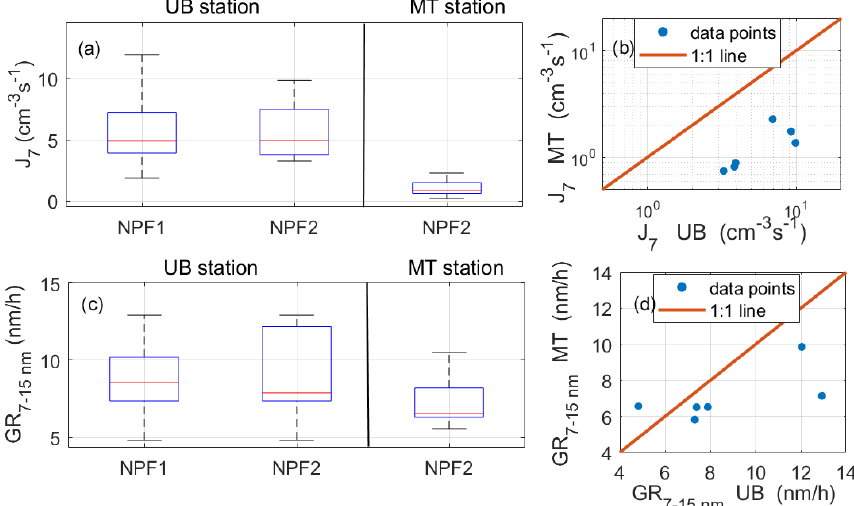
Figure 11. Median and percentages of formation rates of 7nm ( J 7 , cm − 3 s − 1 ) (a) and growth rates from 7 to 15nm (GR 6 − 15nm , nmh − 1 ) (c) measured at both stations during our observation as well as comparison between J 7 (b) and GR 6 − 15nm (d) of common NPF events. The red line represents the median of the data, and the lower and upper edges of the box represent 25th and 75th percentiles of the data, respectively. The length of the whiskers represents 1.5 times the interquartile range, which includes 99.3% of the data. “NPF1” and “non-event1” refer to NPF event and non-event days in summer 2018 and 2019, and “NPF2” and “non-event2” refer to NPF event and non-event days during the observation from 14 June to 14 July 2019.